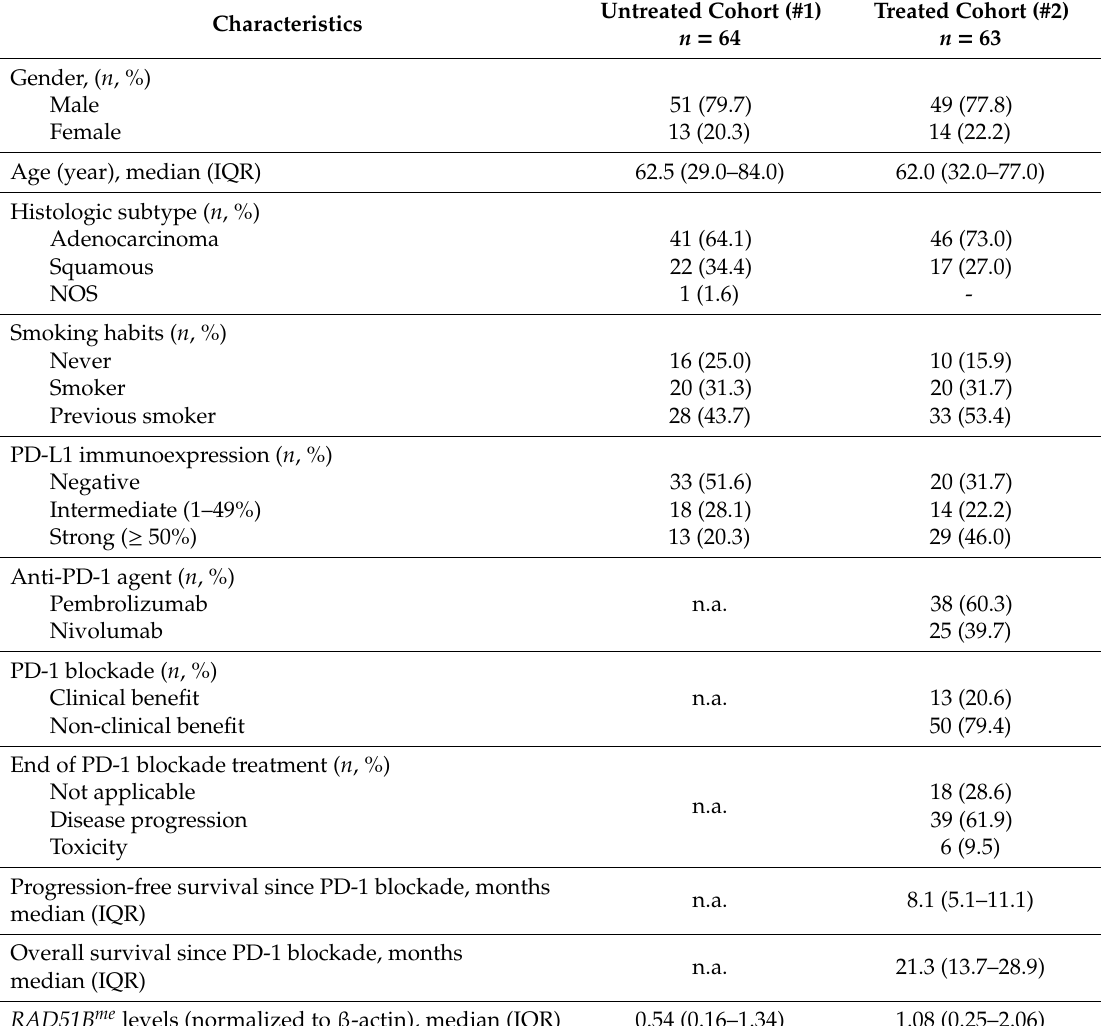
Table 2. Clinical and pathological data according to the testing